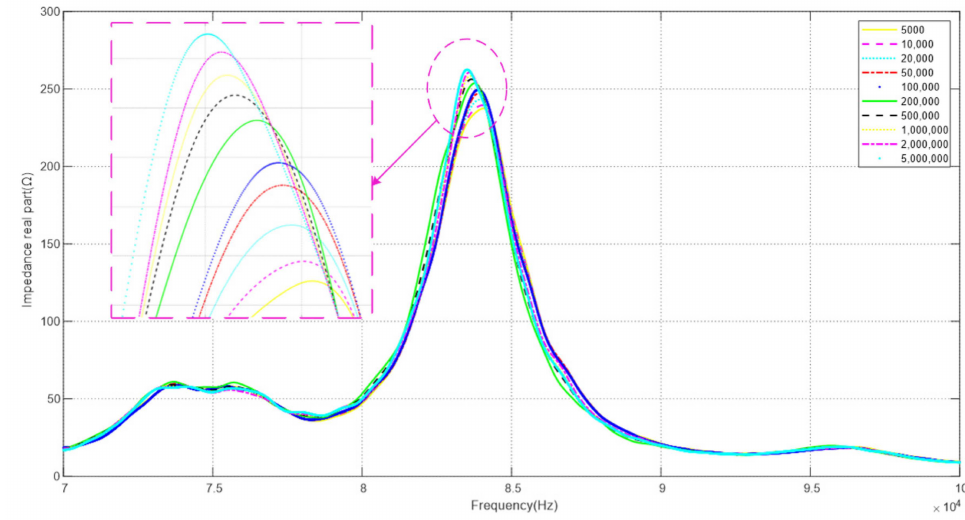
Figure 11. Impedance curves for different viscosity damping fluids. It can be seen from Figure 11 that the maximum of the impedance real part curve gradually shifts to the left as the viscosity of the damping fluid increases. The real resis- tance of the impedance signal also increases little by little. Increasing the viscosity of the damping fluid load increases the inductance and resistance of the equivalent circuit and the damping of the system, which decreases the series resonance frequency and increases the real resistance. When the damping fluid viscosity is 5000 cSt, the peak frequency of the impedance curve is 84.058 kHz and the real resistance of the impedance curve is 237.4 Ω . When the damping fluid viscosity is 5,000,000 cSt, the peak frequency of the impedance curve is 83.512 kHz and the real resistance of the impedance curve is 262.5 Ω . Figure 12 shows the relationship between the fluid viscosity and the peak frequency, and Figure 13 shows the relationship between the fluid viscosity and the real resistance.